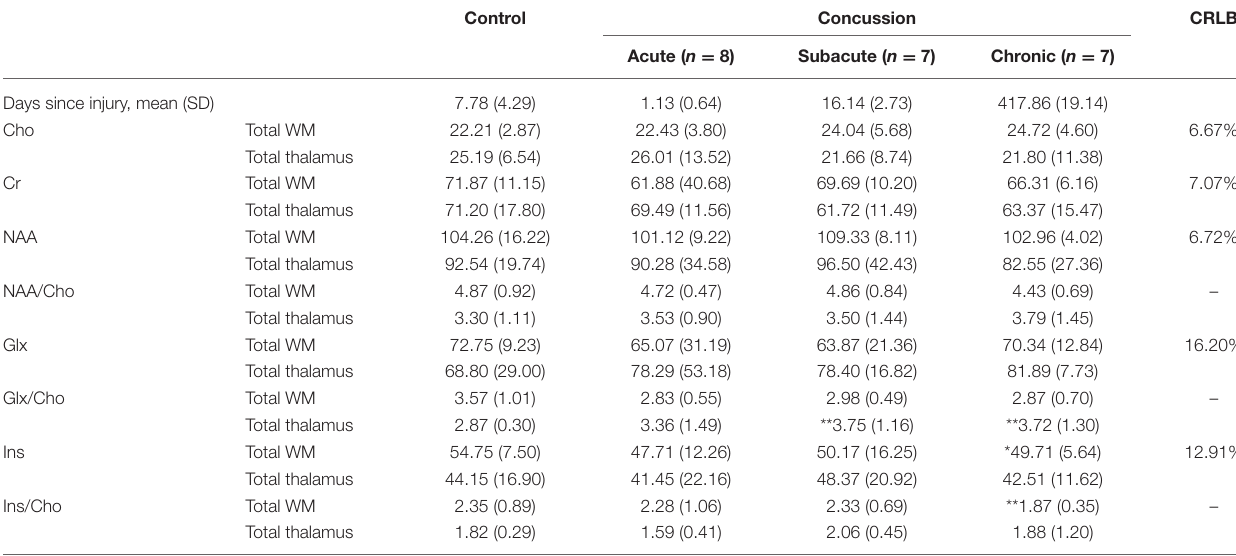
TABLE 2 | Median metabolite concentrations (mM), or concentrations ratios, and interquartile range by group and time point. Control